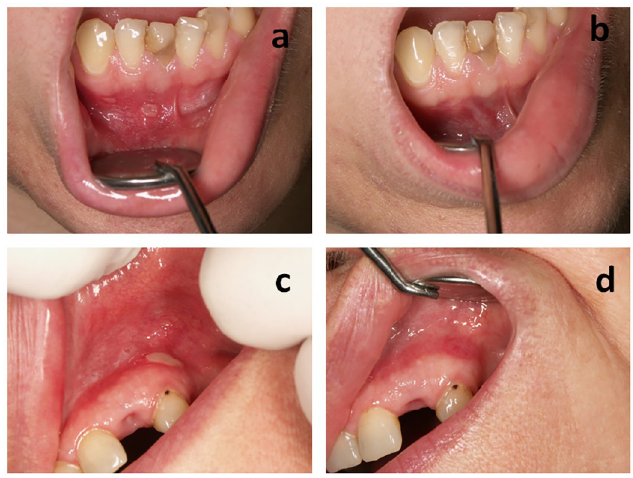
Fig 3. RAS lesion on day 0 (a) and on day 5 (b) of NAVS treatment , and on day 0 (c) and on day 5 (d) of betamethasone treatment.